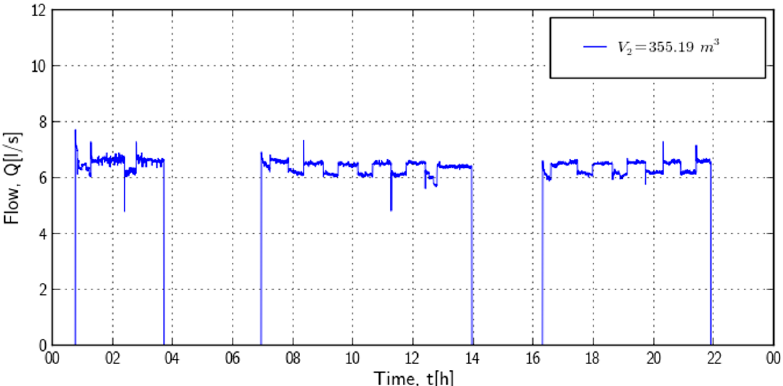
Figure 7. The PU2 flow change diagram Q(t) on 30 December 2009.